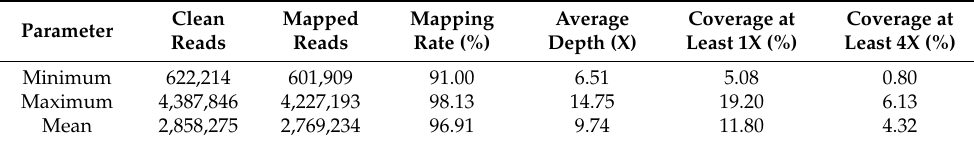
Table 2. Statistics of sequencing depth and coverage.